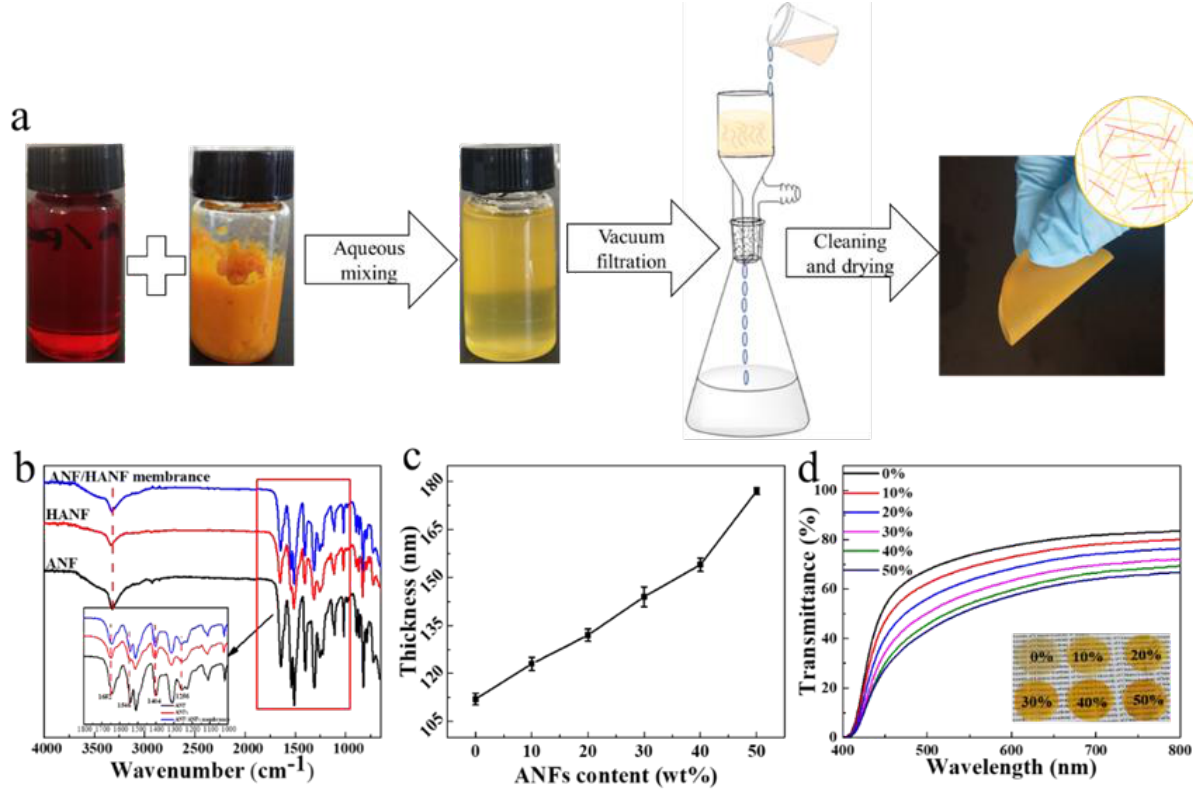
Figure 2. ( a ) Procedure employed to manufacture ANF/HANF membranes. ( b ) FTIR spectra of ANF, HANFs and ANF/HANF membrane (HANF composition: 10 wt%). ( c ) The change of the film thickness with the HANF content. ( d ) Transparency performance of the ANF/HANF